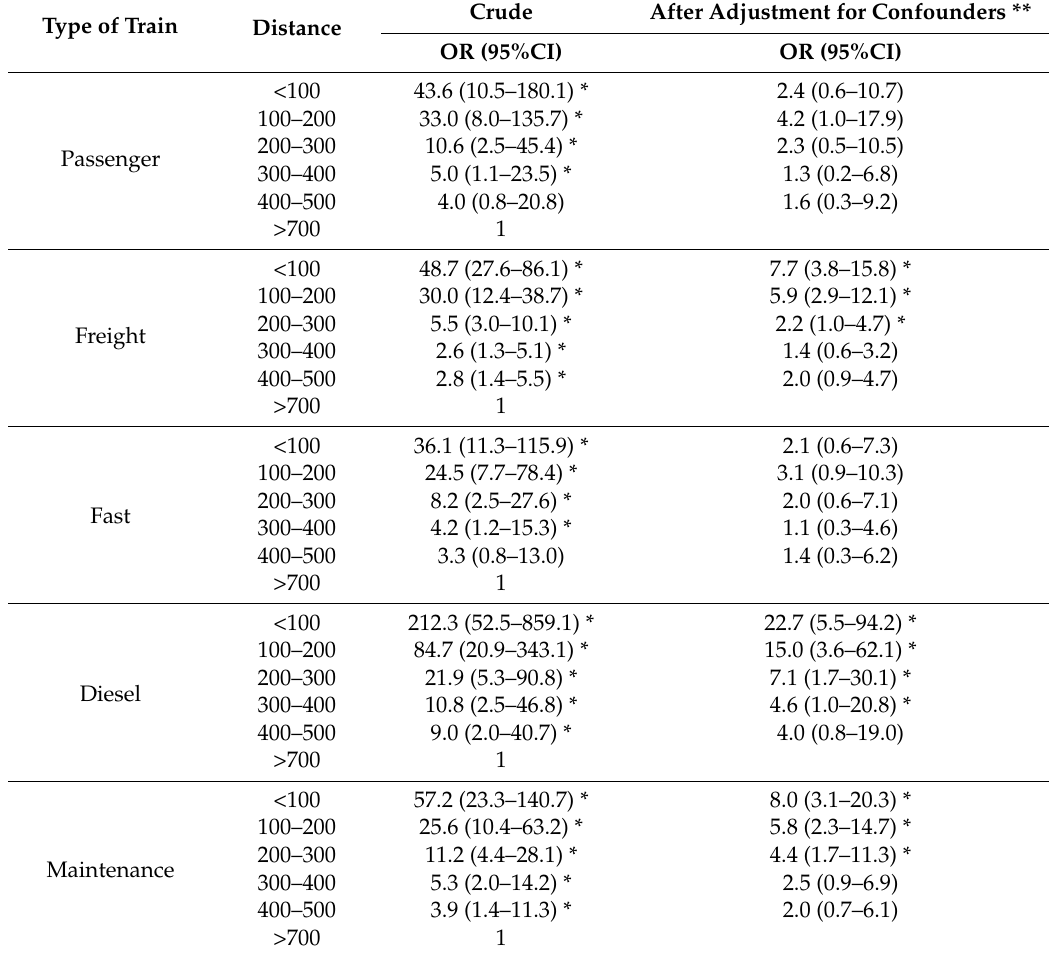
Table 4. The association between distance and high annoyance due vibrations from different rail traffic